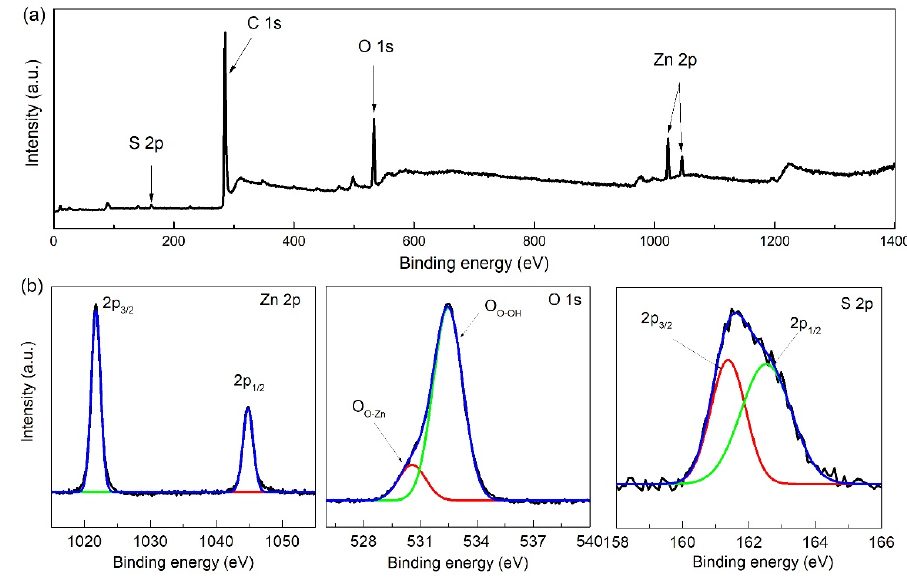
Figure 4. XPS spectra of dried PVA ‐ ZnOS200: ( a ) survey spectrum and ( b ) deconvoluting high ‐ resolution spectra of Zn2p, S2p, and O1s, respectively.